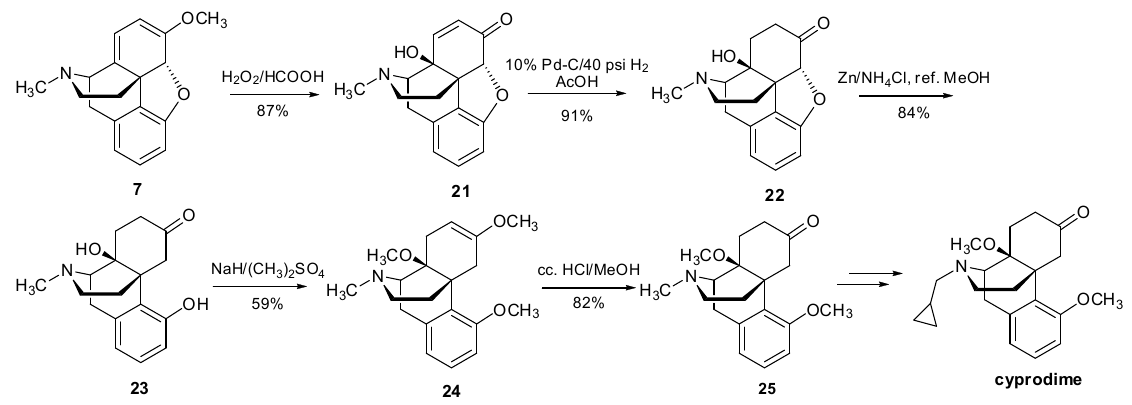
Scheme 3. New route to key intermediate 25 of the synthesis of